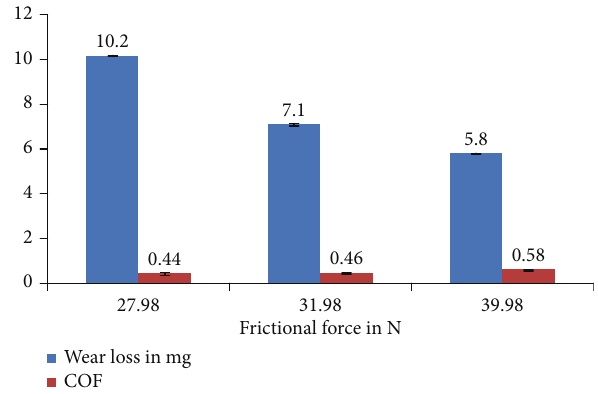
Figure 7: Comparisons and e ff ect of the frictional force on wear loss and COF of silver matrix hybrid